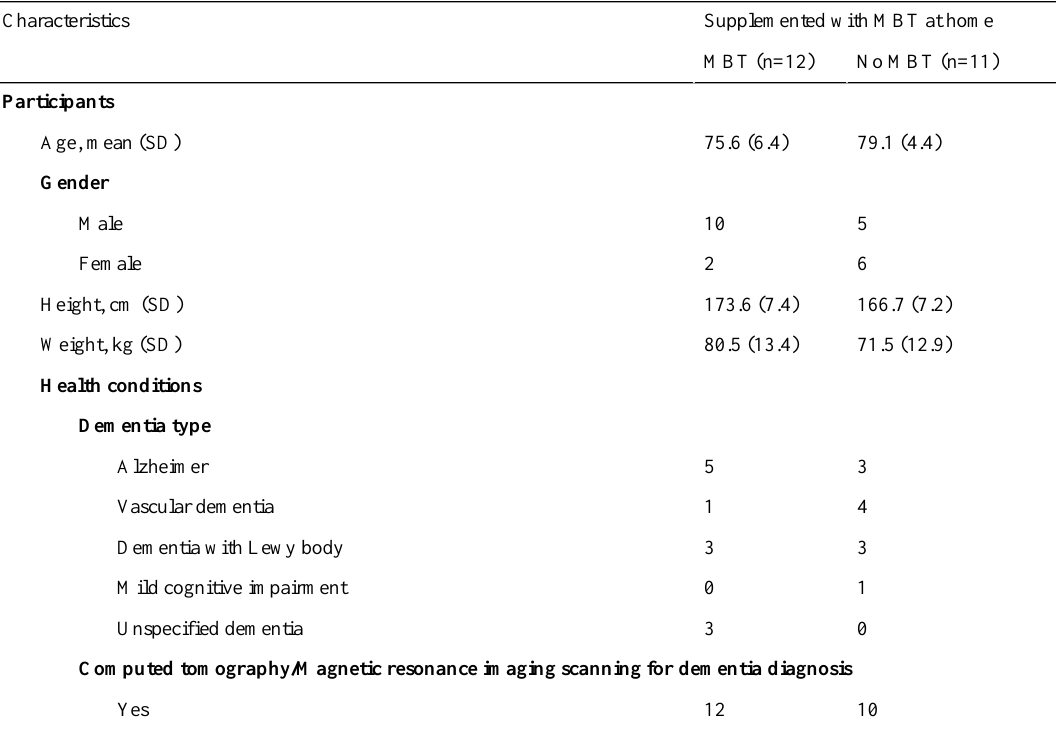
Table 1. Characteristics of the participants at baseline (n=23) by the status of supplemental at-home MBT a training.